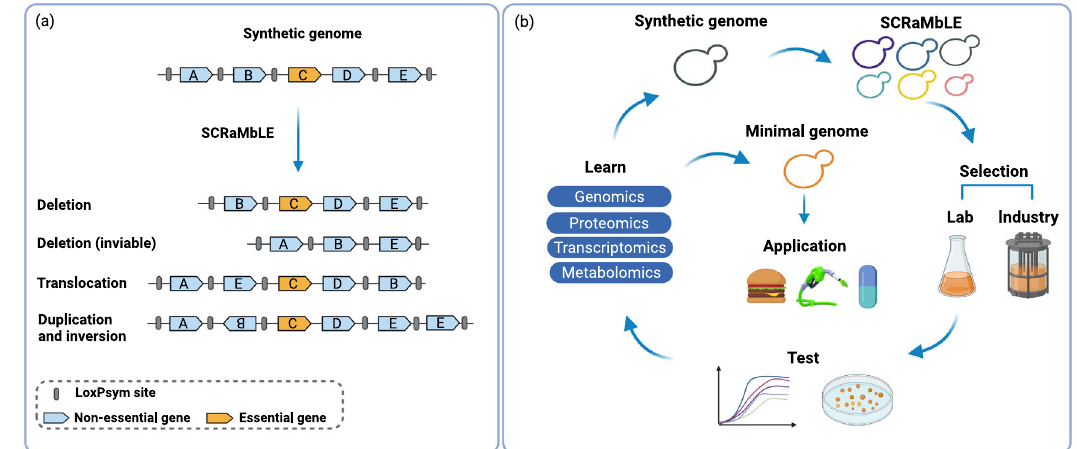
Fig. 4 | Genome minimisation by SCRaMbLE. a Genome diversity generated by SCRaMbLE.LoxPsymsitesareinsertedinthe3 ’ UTRofallnon-essentialgenes.Upon induction of SCRaMbLE, various genome rearrangement events can happen, for example,deletion of non-essential gene ‘ A ’ , translocationof ‘ E ’ and ‘ B ’ ,inversion of ‘ B ’ and duplication of ‘ E ’ . However, deletion of a gene-cassette containing essential gene ‘ C ’ leads to cell death. b Creationof minimaland industrial-minimalgenomes viaSCRaMbLE. Genome rearrangementsincluding deletionsoflarge segmentscan occuruponactivationofSCRaMbLE.Appliedwithappropriateselectionpressures,